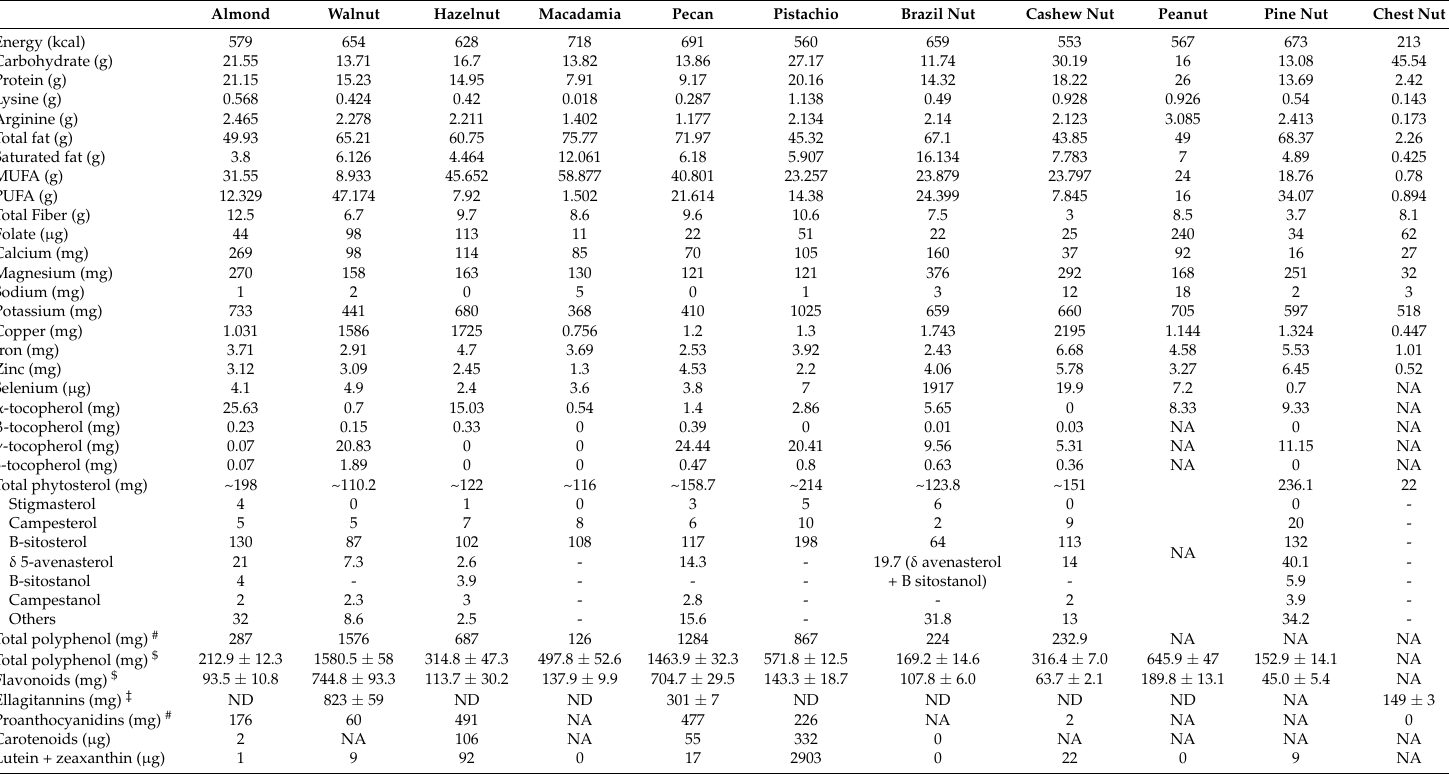
Table 1. Nutrient content of raw nuts per 100 g